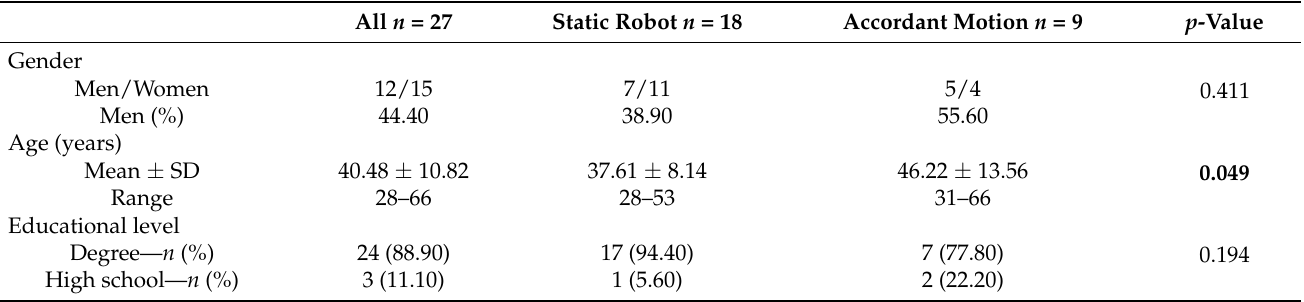
Table 3. Participant